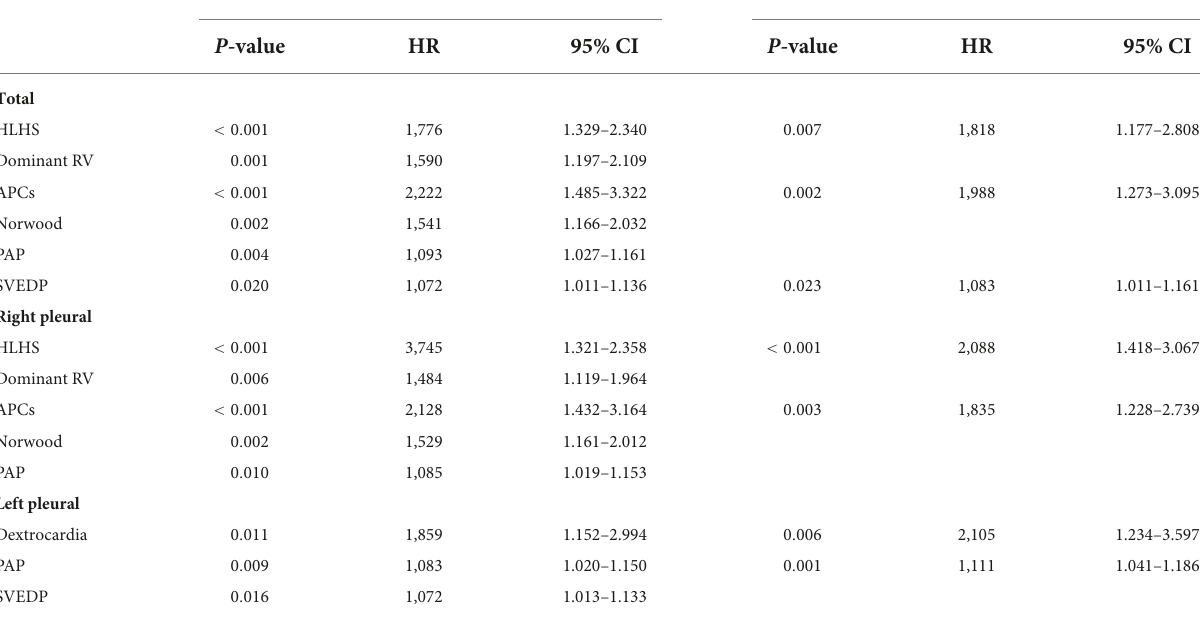
TABLE 4 Factors associated with duration of drainage.